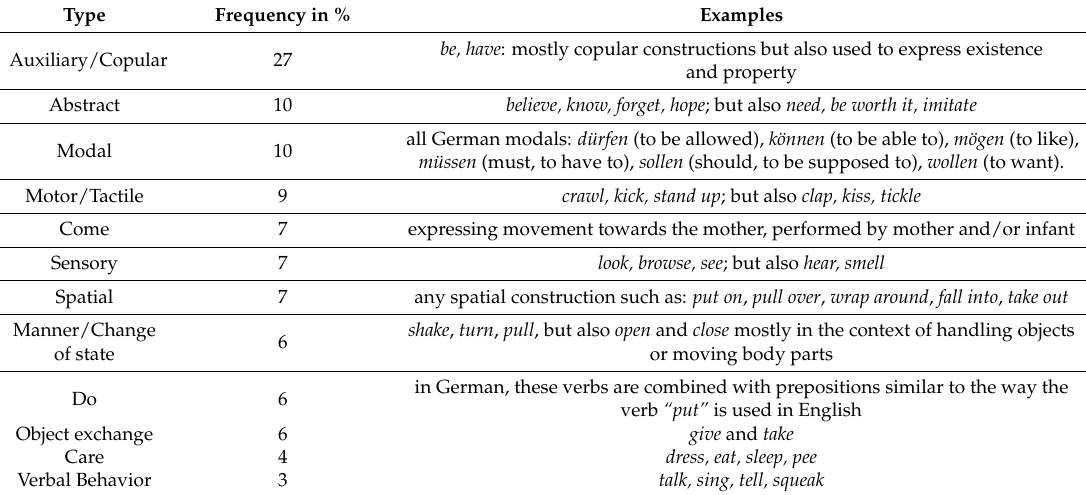
Table 3. Types of verbs in the